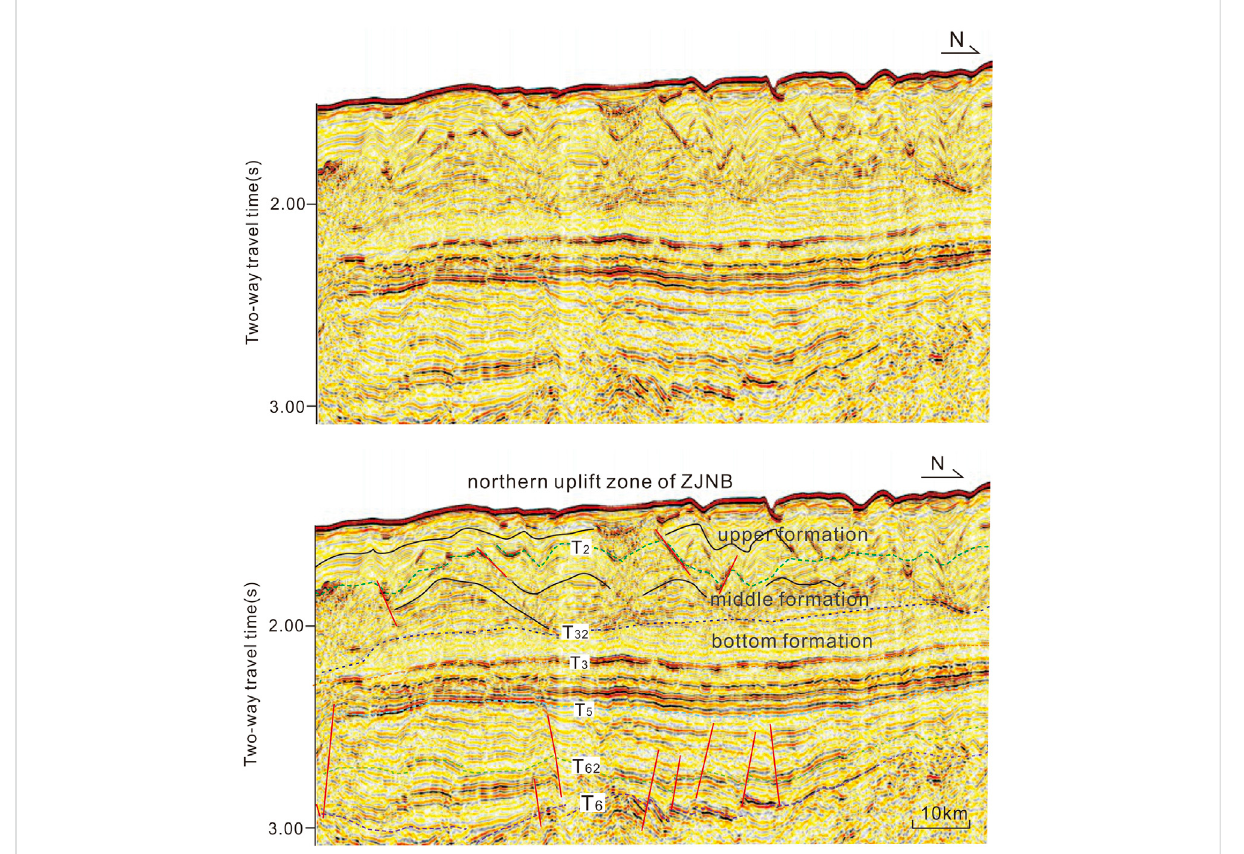
FIGURE 4 Sedimentary-structure development characteristics in the southern Zhongjiannan Basin (See line A3 in Figure 1 for pro fi le